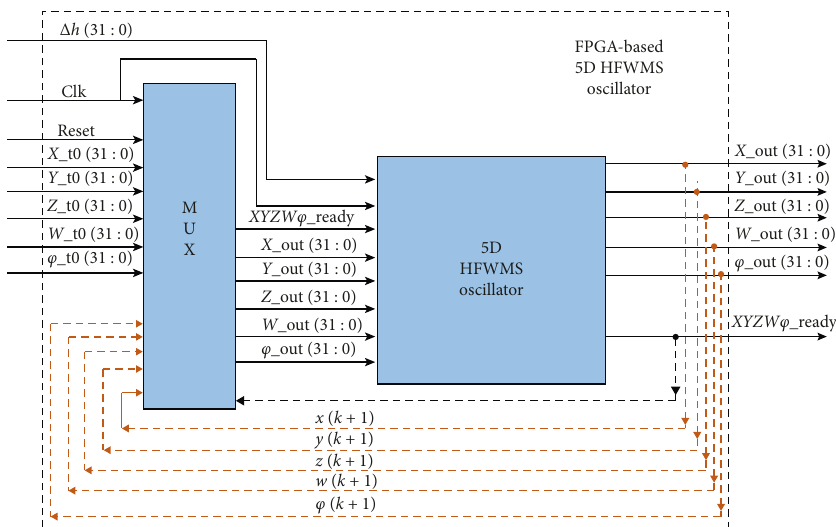
Figure 11: The second-level block diagram of the FPGA-based 5D HFWMS.